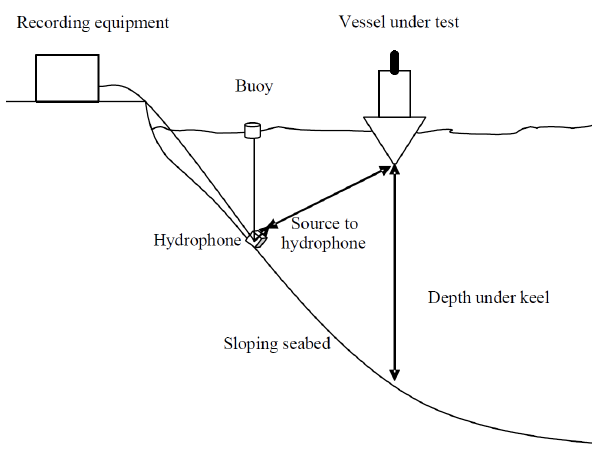
Figure 5: Sketch for underwater noise measurements (from [52]).